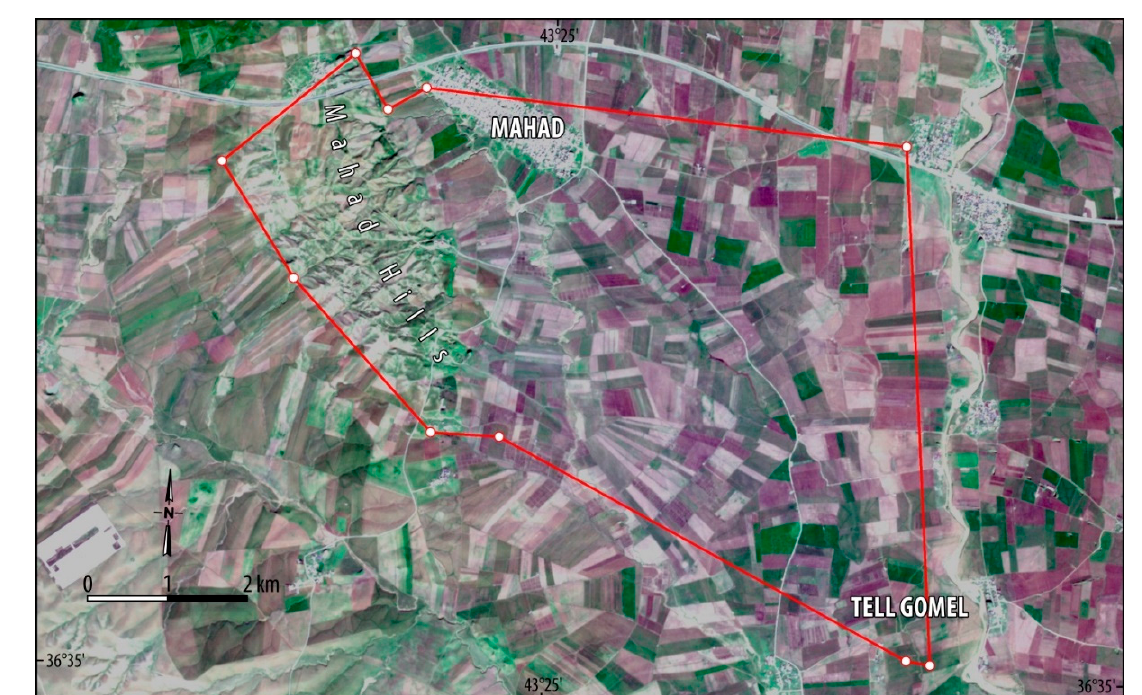
Figure 2. Area of interest. Background image © EU ‐ Sentinel. CC234(TC), 10 January 2019.